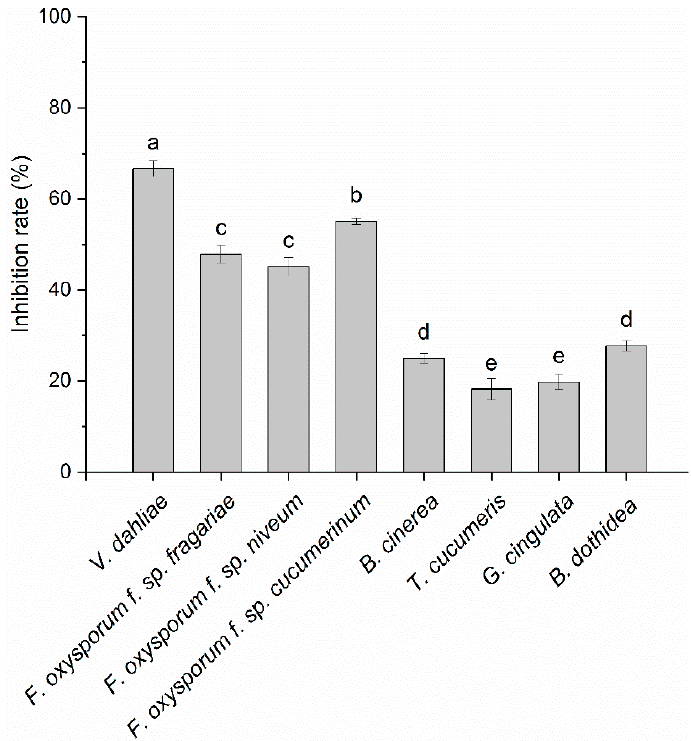
Figure 1. Inhibitory effect of volatile organic compounds (VOCs) produced by strain CT32 on the mycelial growth of 8 plant pathogenic fungi. Values with different lowercase letters are significantly different according to Duncan’s multiple range test at the 0.05 level.